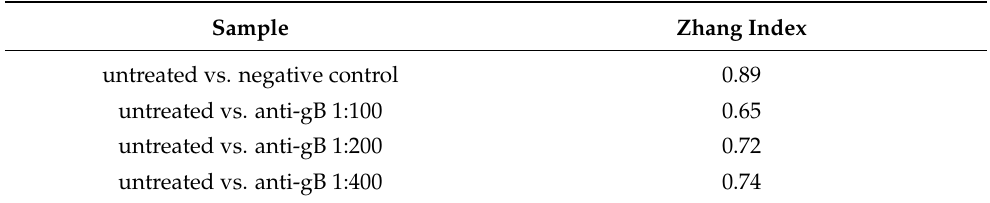
Table 1. Zhang indices of HSV-1-specific SRFIA on 96 well plate calculated based on at least n = 8 values each.